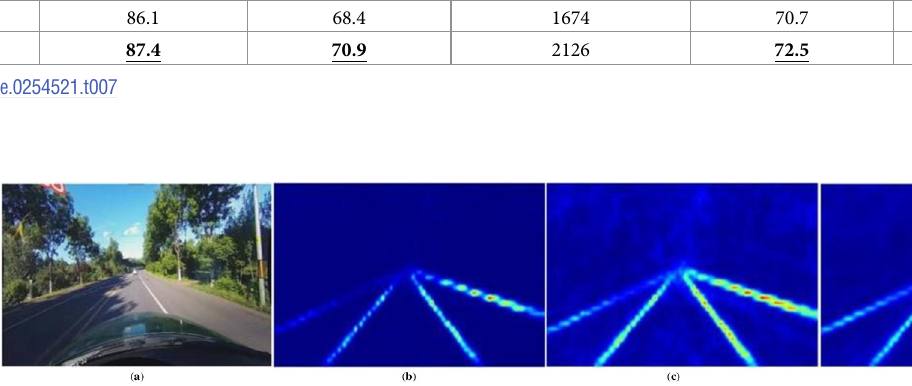
Fig 8. Heatmap of GAAN with different modules: ( a ) Input; ( b ) Seg; ( c ) GAA module; ( d ) SPFU.